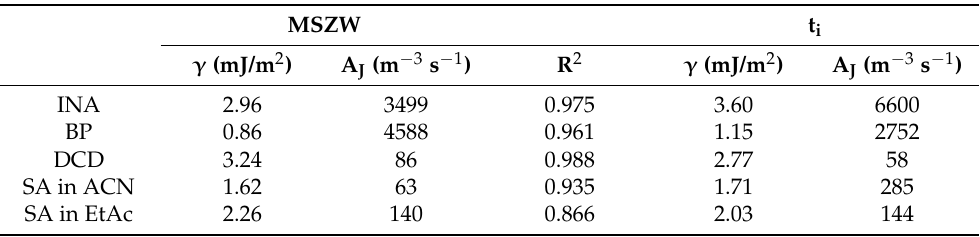
Table 1. Comparison of γ and A J obtained from the MSZW and induction time data for some crystallization systems. MSZW t i